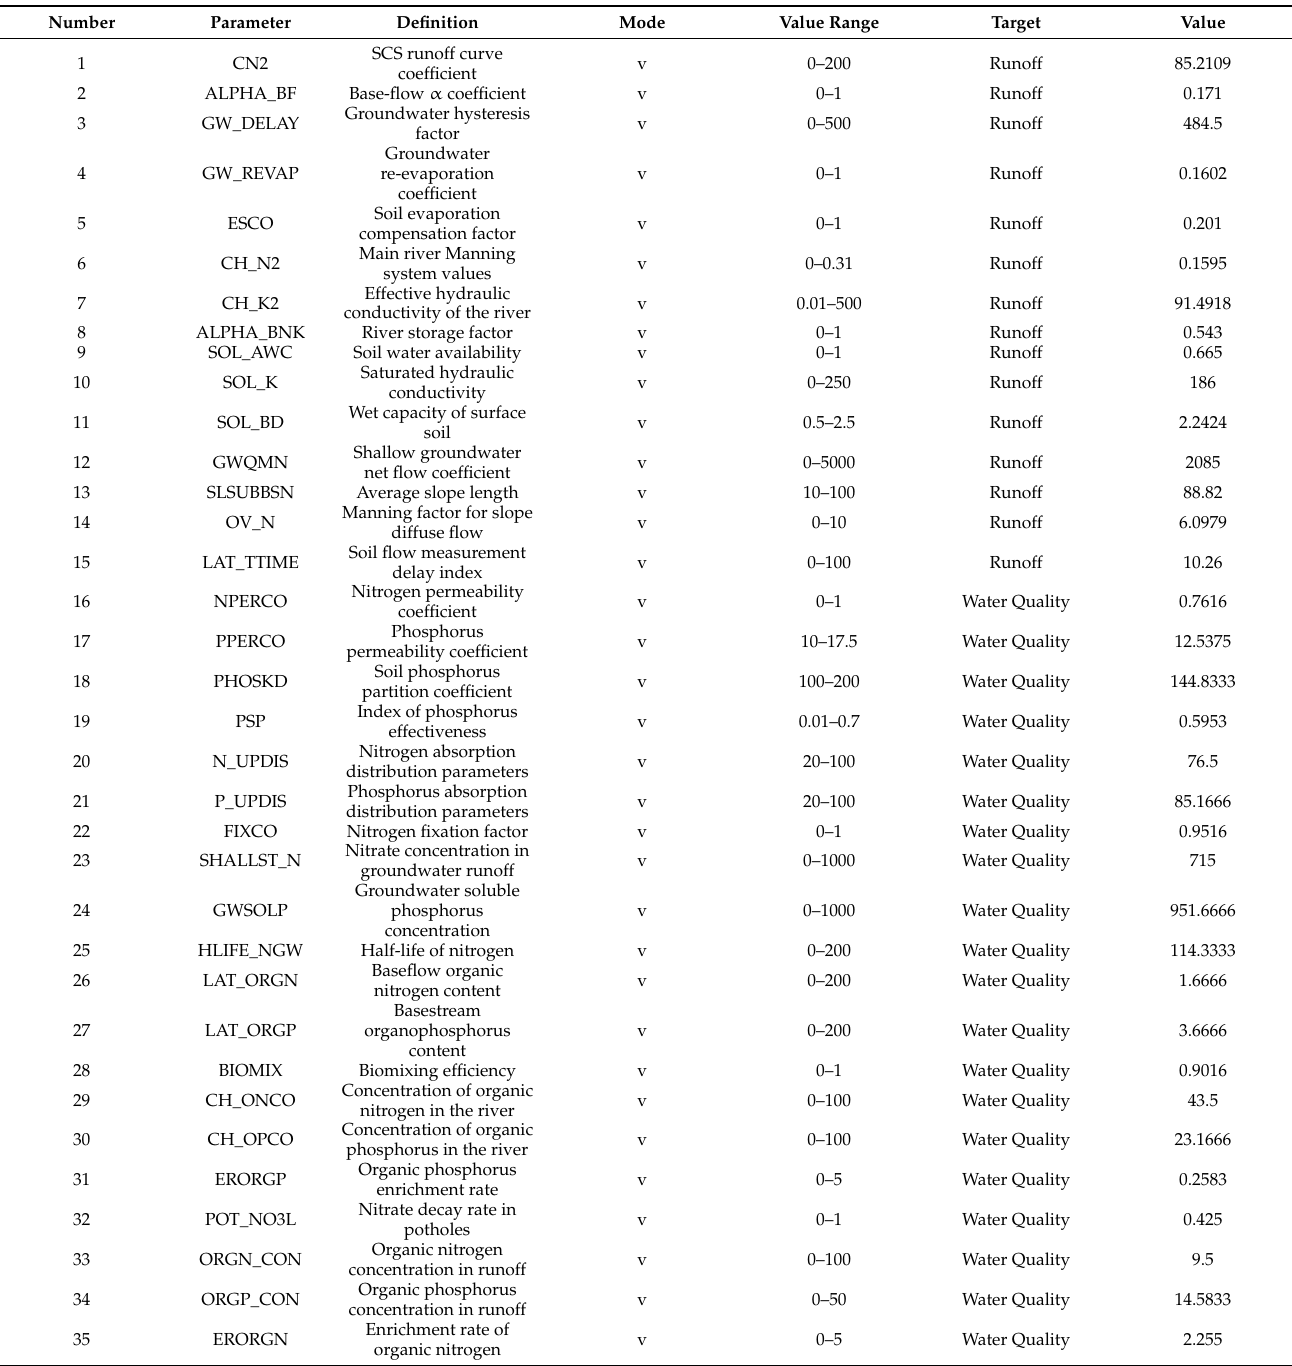
Table 5. Meaning and value of